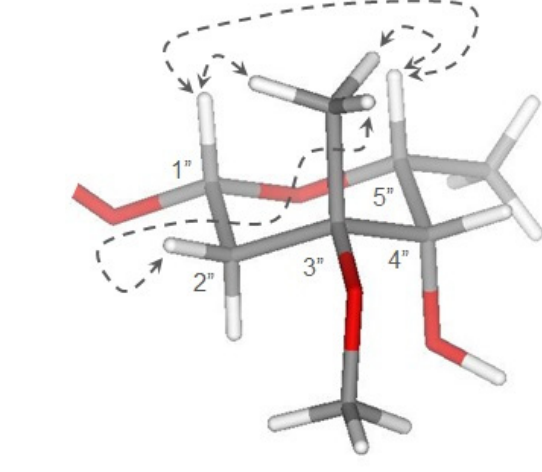
Figure 1. Conformation of cladinose sugar in 3 and 4 with most important nOe interactions (not energy minimized, for illustrative purposes only).